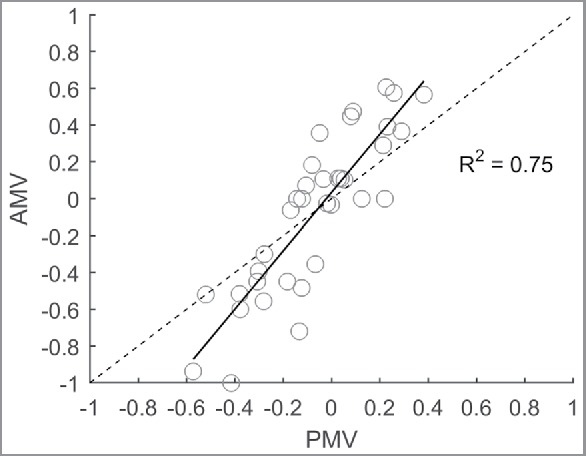
AMV versus PMV using an assumed metabolic rate of 1.5 Met and the line of identity (dashed).